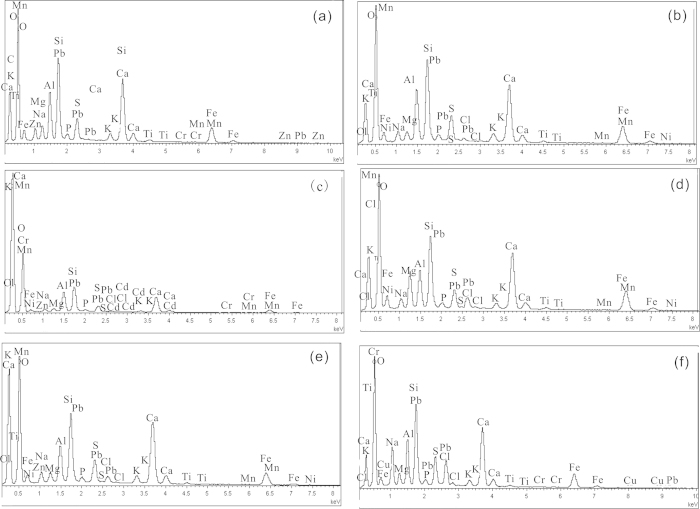
EDS photographs of fly ash with (a) 0% chlorination agent (b) 10% CaCl2 (c) 10% MgCl2 (d) 10% FeCl3 (e) 10% AlCl3 and (f) 10% NaCl after incineration at 1000 °C for 60 min.